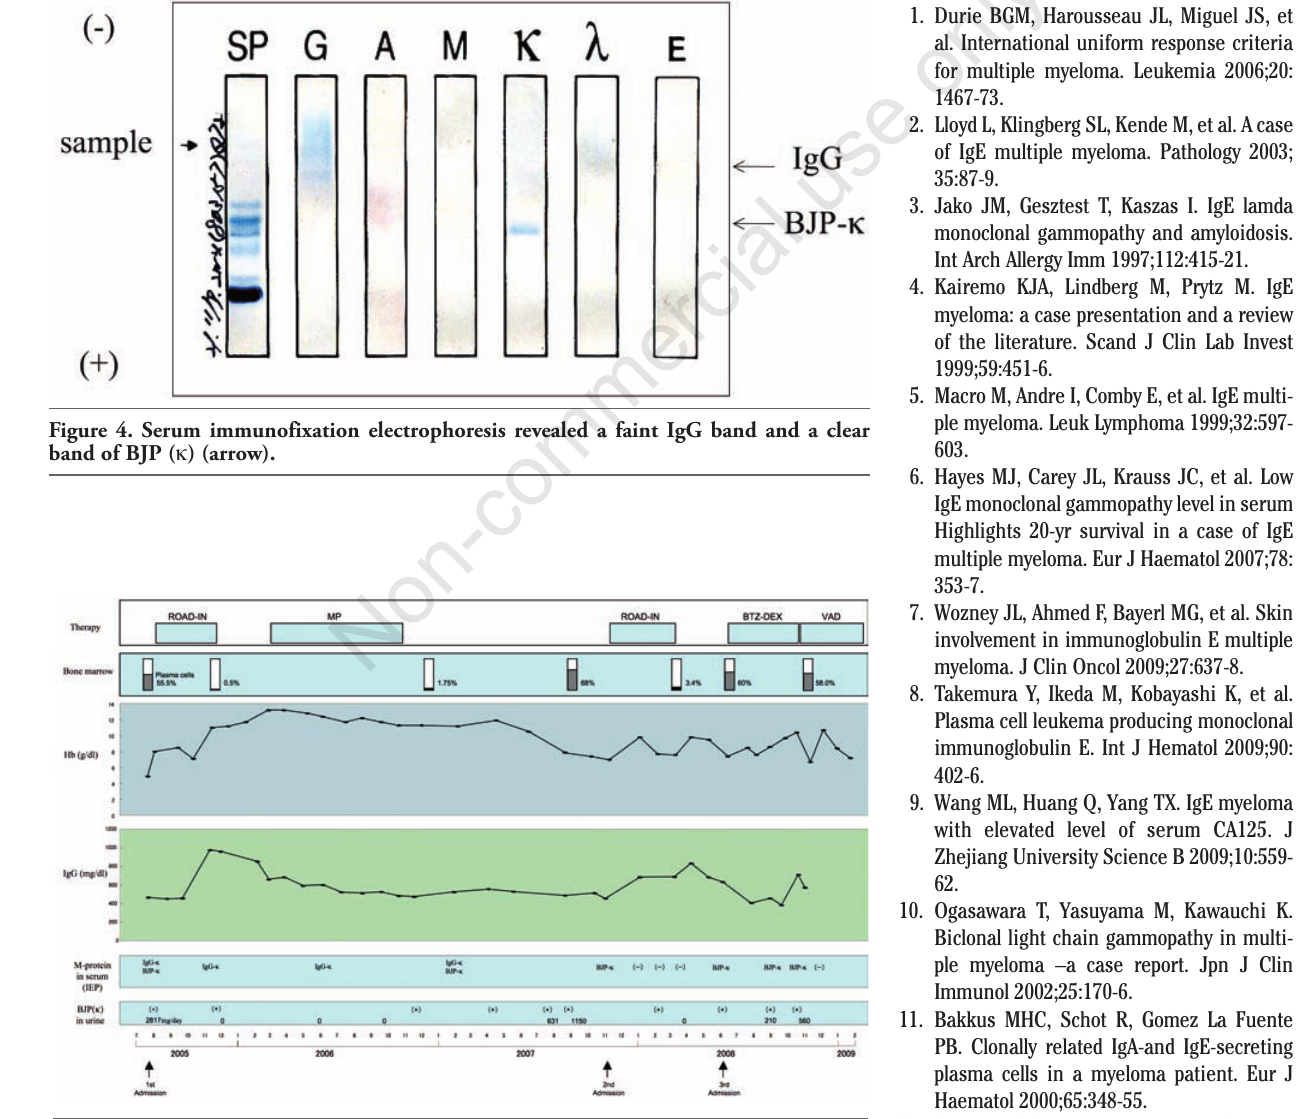
Figure 5. Patient’s clinical